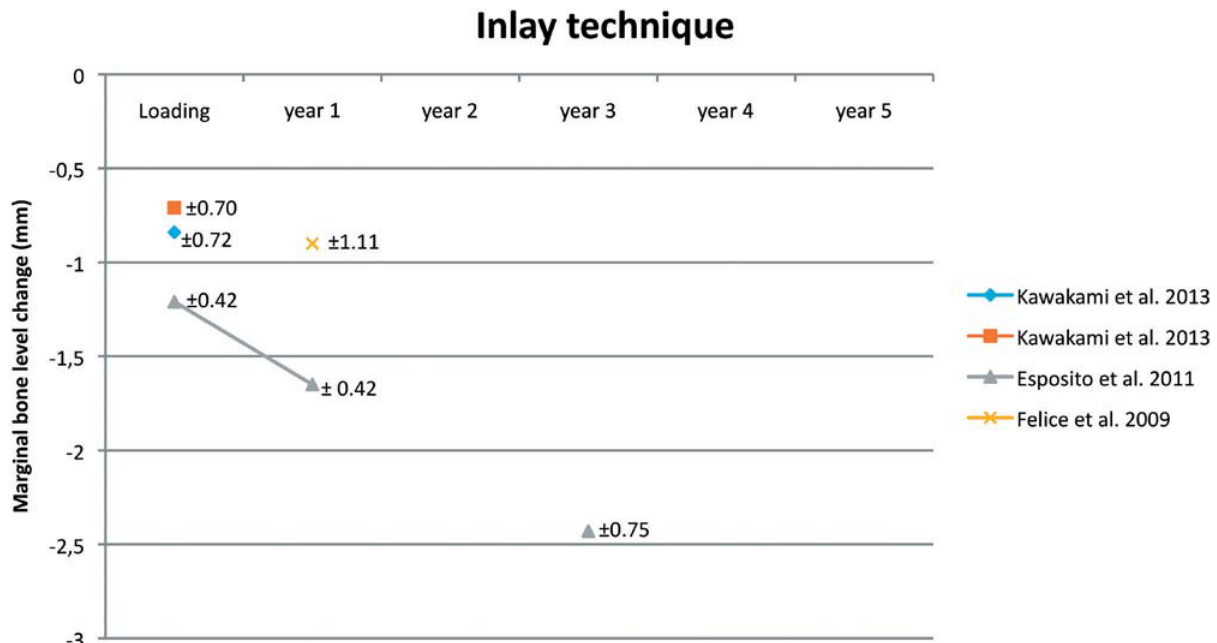
Figure 4- Inlay technique. Mean and Standard Deviation are